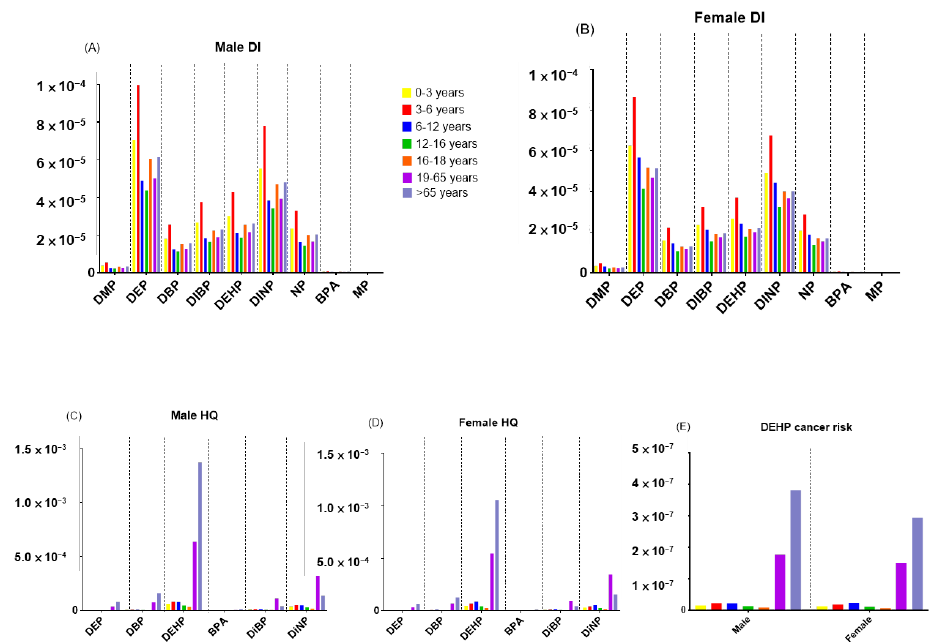
Figure 3. The estimated health risk assessment EEDCs through the consumption of estuarine fish collected from northern rivers, Taiwan, for different populations among age groups:( A ) DI values of Male ( B ) DI values of Female ( C) HQ values of Male ( D ) HQ values of Female ( E ) The values of cancer risk for DEHP.